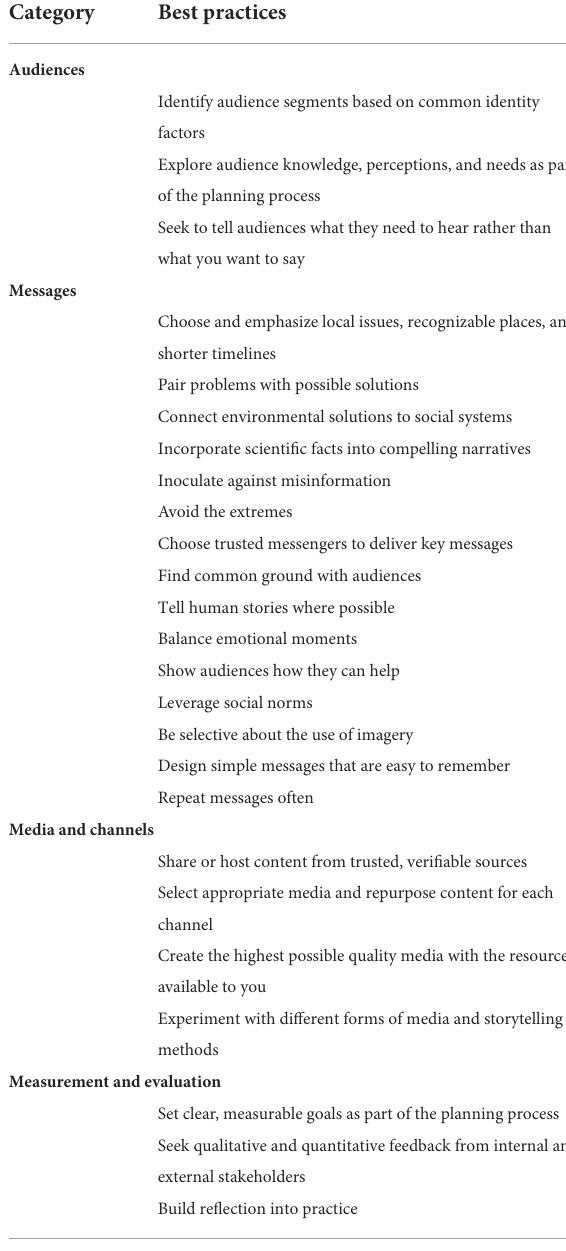
TABLE 2 Evidence-based practices for environmental